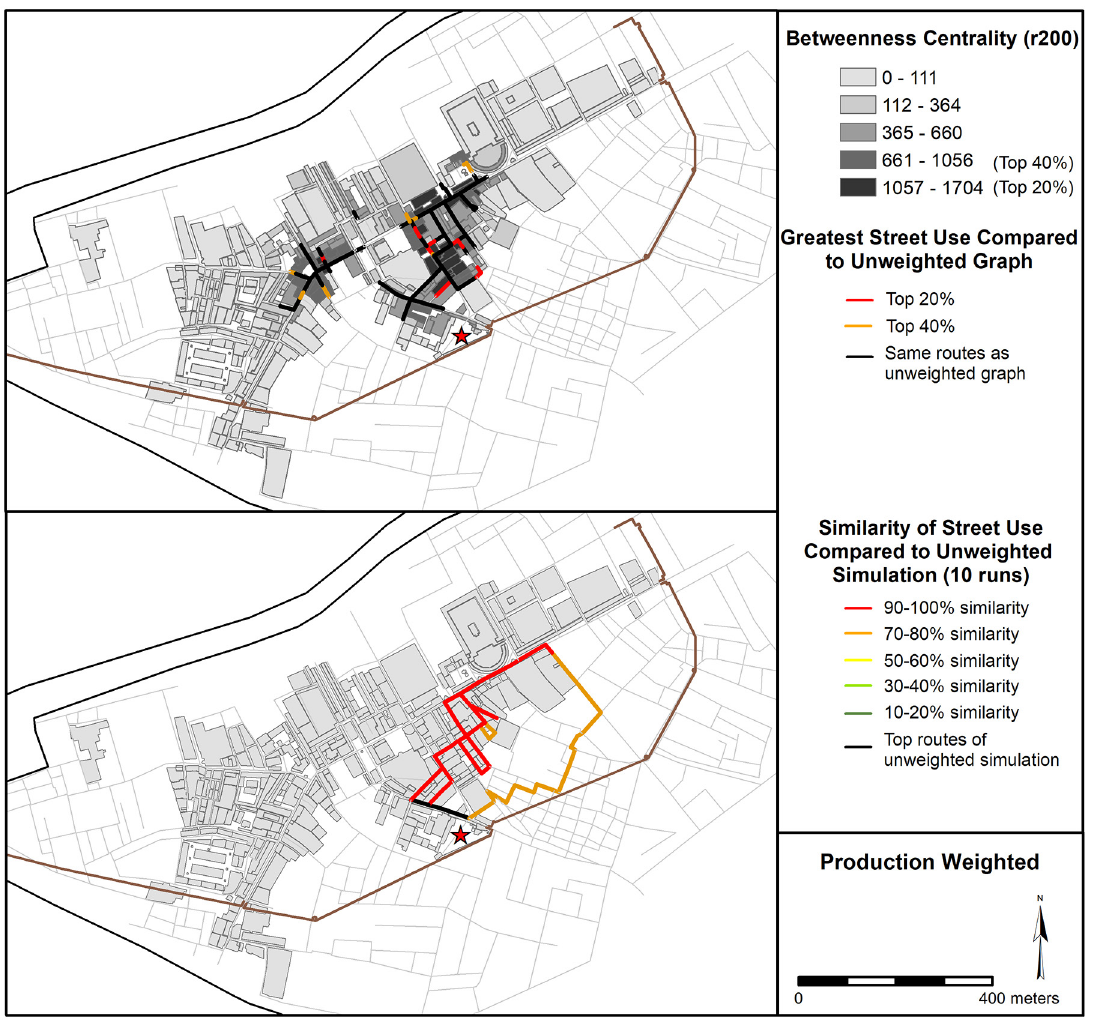
Figure 9. Top: Betweenness centrality graph weighted by production buildings. Streets displayed in red and orange follow the highest betweenness centrality metrics which are different from the unweighted graph. Bottom: Similarity of street usage by processional runs weighted by production